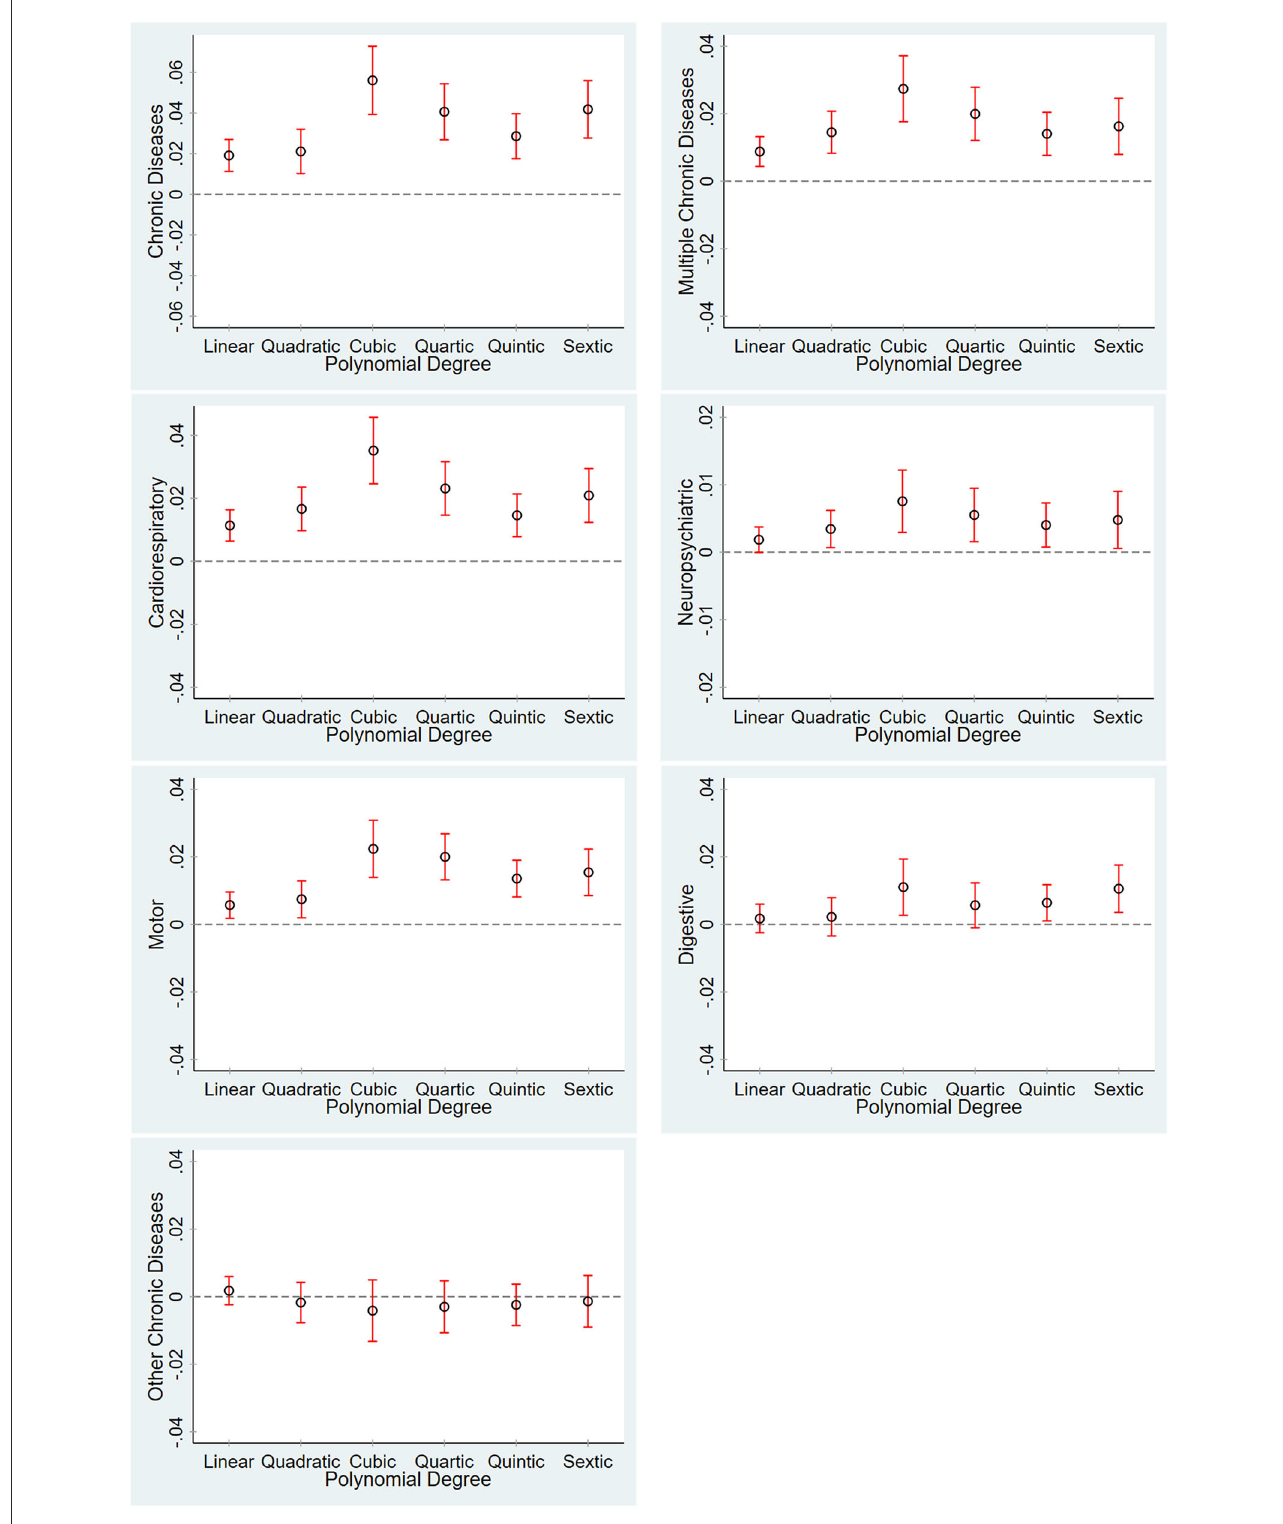
FIGURE2 Robustness test for different RD polynomials. The graphs show the point estimates for the effect of PM 2.5 on health outcomes and the associated 95% confidence intervals when the degree of the polynomial used in regression varies between linear and sextic. All the graphs show the 2SLS IV estimates and include all the covariates listed in Table